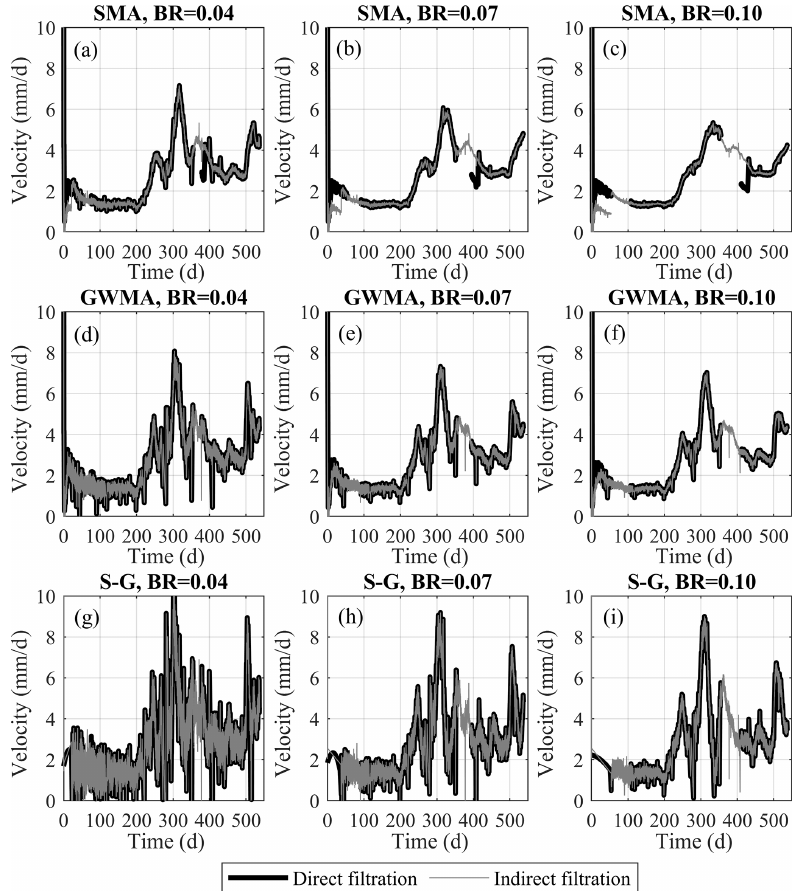
Figure 17. Indirect and direct filtration results of Geocube no. 46 velocity values for bandwidth ratio (BR) values of (a) 0.04, (b) 0.07, and (c)